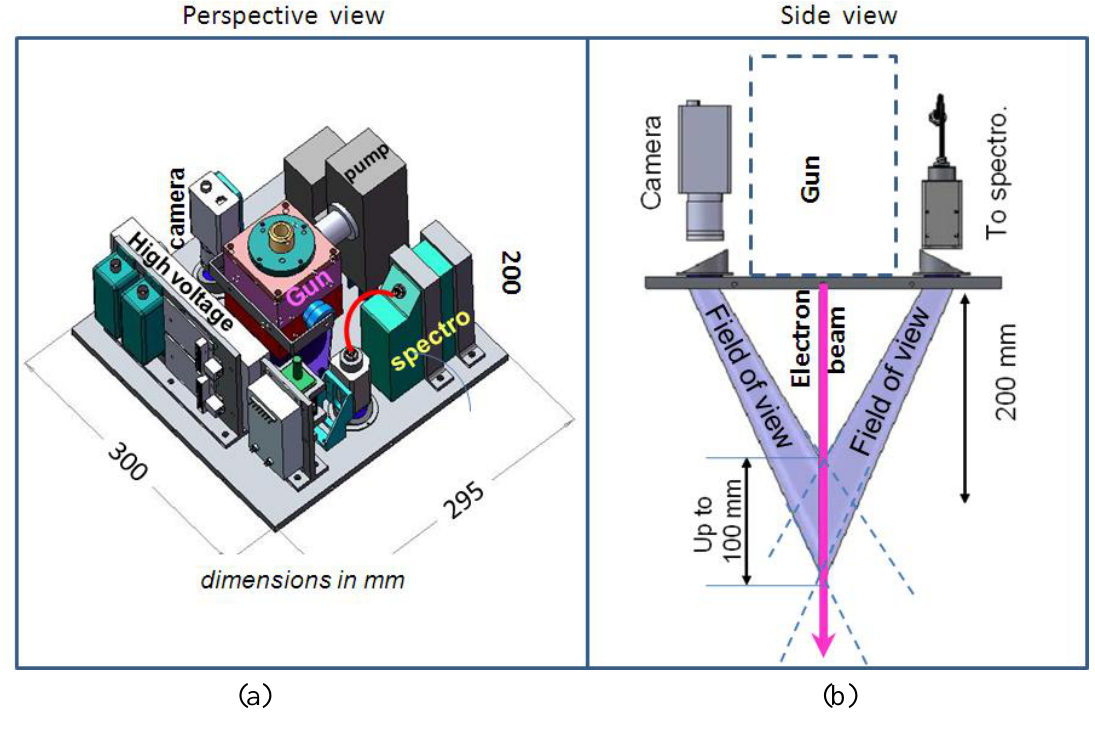
Figure 5. (a) Layout of the Electron Beam Fluorescence integrated instrument. (b) Optical detectors